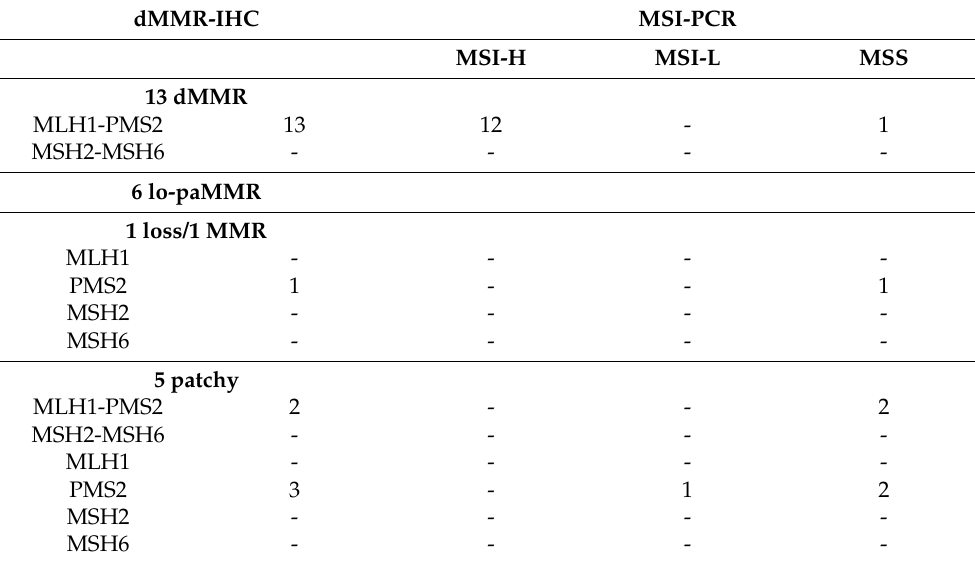
Table 5. Comparison between MMR-IHC and RT-PCR results in our GCs